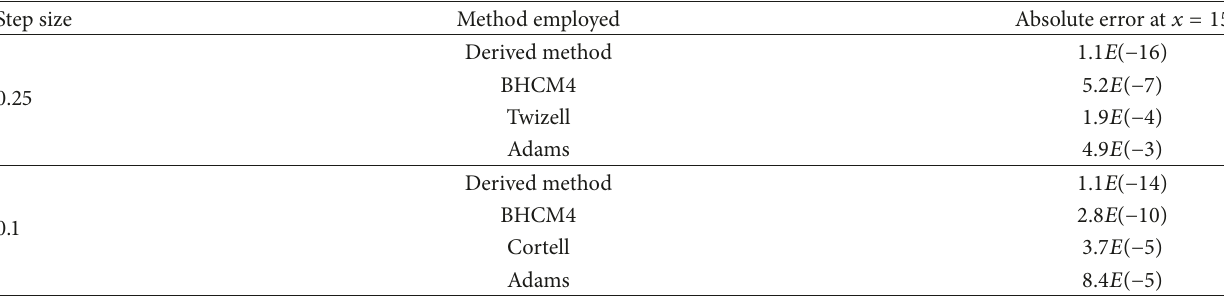
Table 4: Comparison of the proposed method with [15] for the case 𝜖 = 0 .